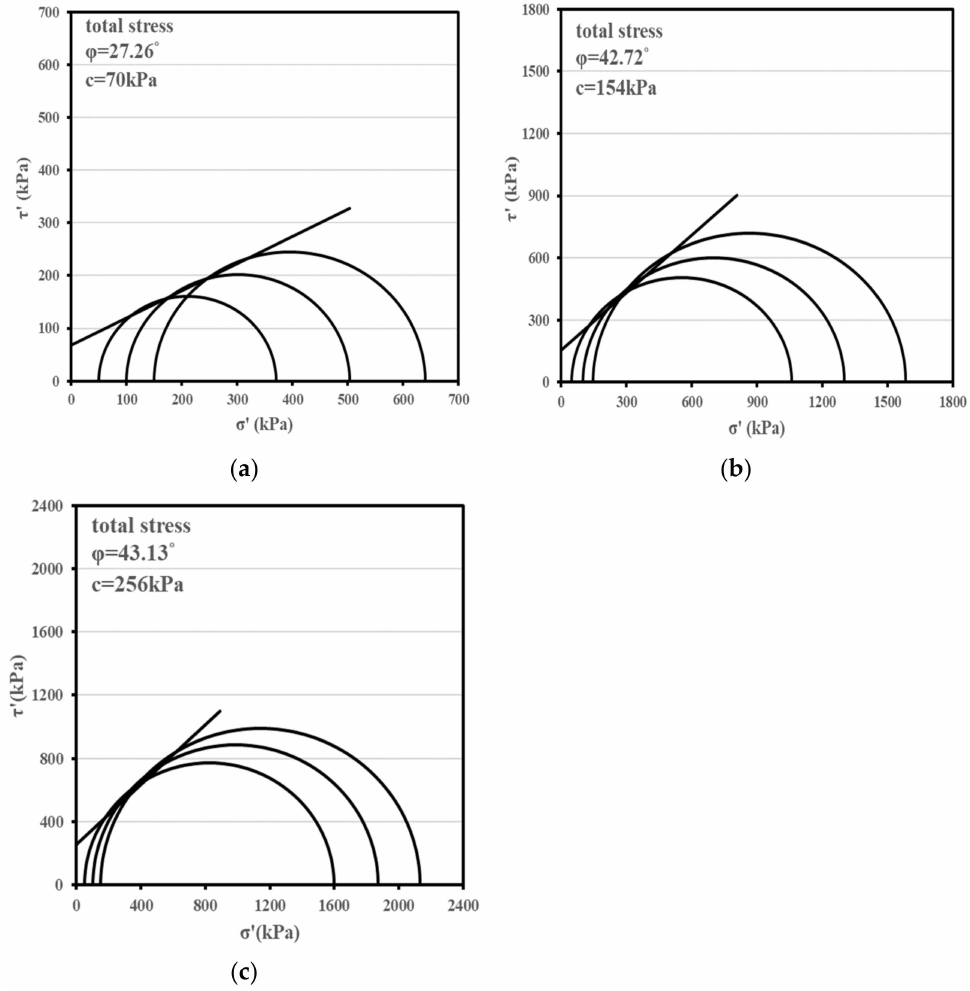
Figure 14. Mohr circle and shear strength parameters of the soil samples for triaxial Unsaturated Unconsolidated Undrain tests: ( a ) UU-0%; ( b ) UU-4%; ( c )